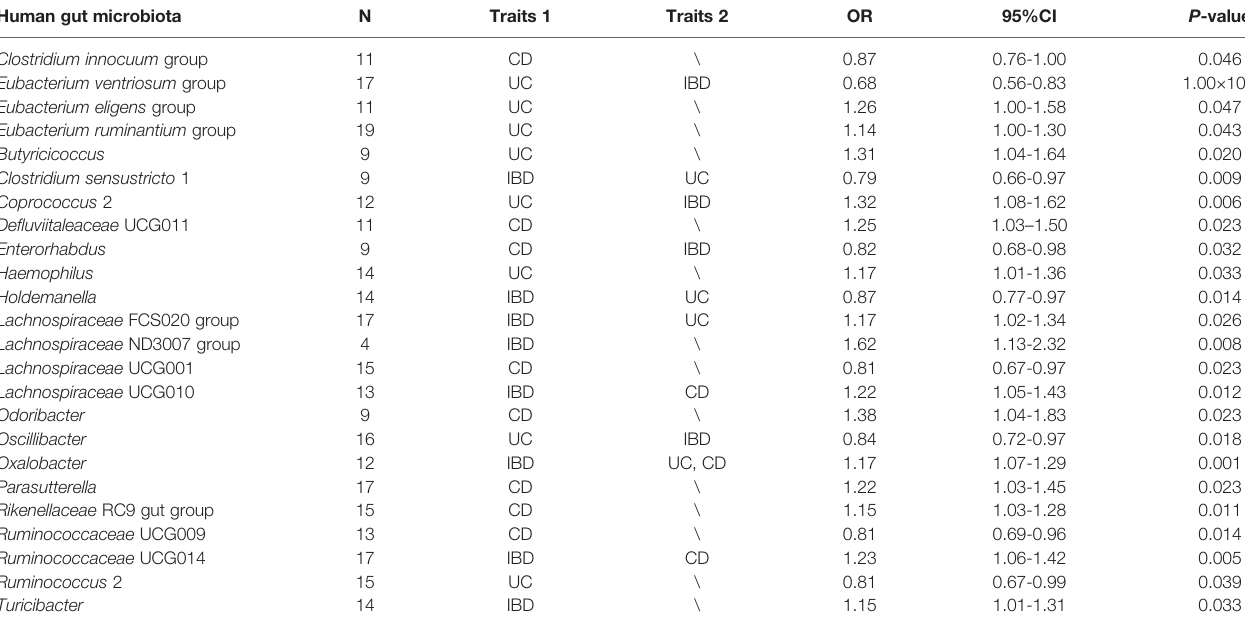
TABLE 1 | Summary of causal association between gut microbial genera and the risk of IBD, UC, or CD by using the IVW method. Human gut